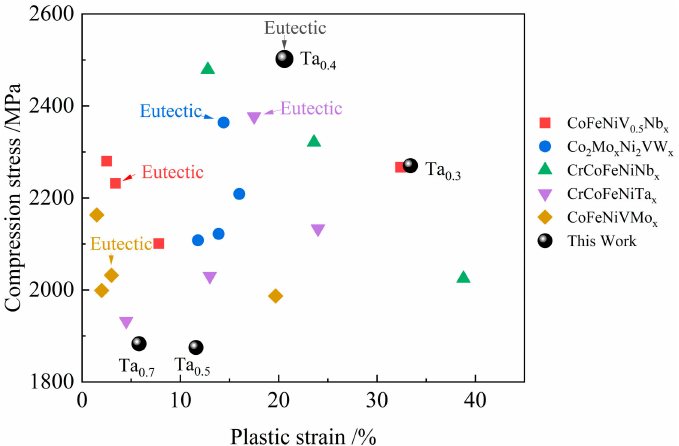
Figure 9. Compression strength and plastic strain of some typical EHEAs compared with CrCoNiTa x EMEA: CoFeNiV 0.5 Nb x [30], Co2Mo x Ni2VW x [32], CrCoFeNiNb x [11], CoCrFeNiTa x [12], CoFeNiVMo x [33] and CrCoNiTa x (this